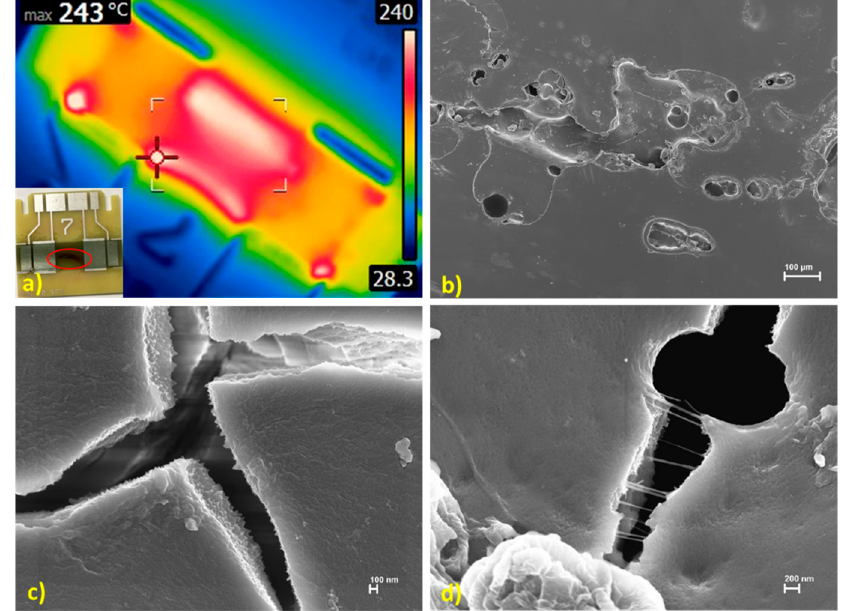
Figure 7. Images of 0.014 wt% sample taken to point of visible failure of epoxy-CNT composite. ( a ) FLIR and photo image; ( b ) SEM image of failure area; ( c ) SEM image of failure area location devoid of CNTs; and ( d ) SEM image of failure area location with CNTs .